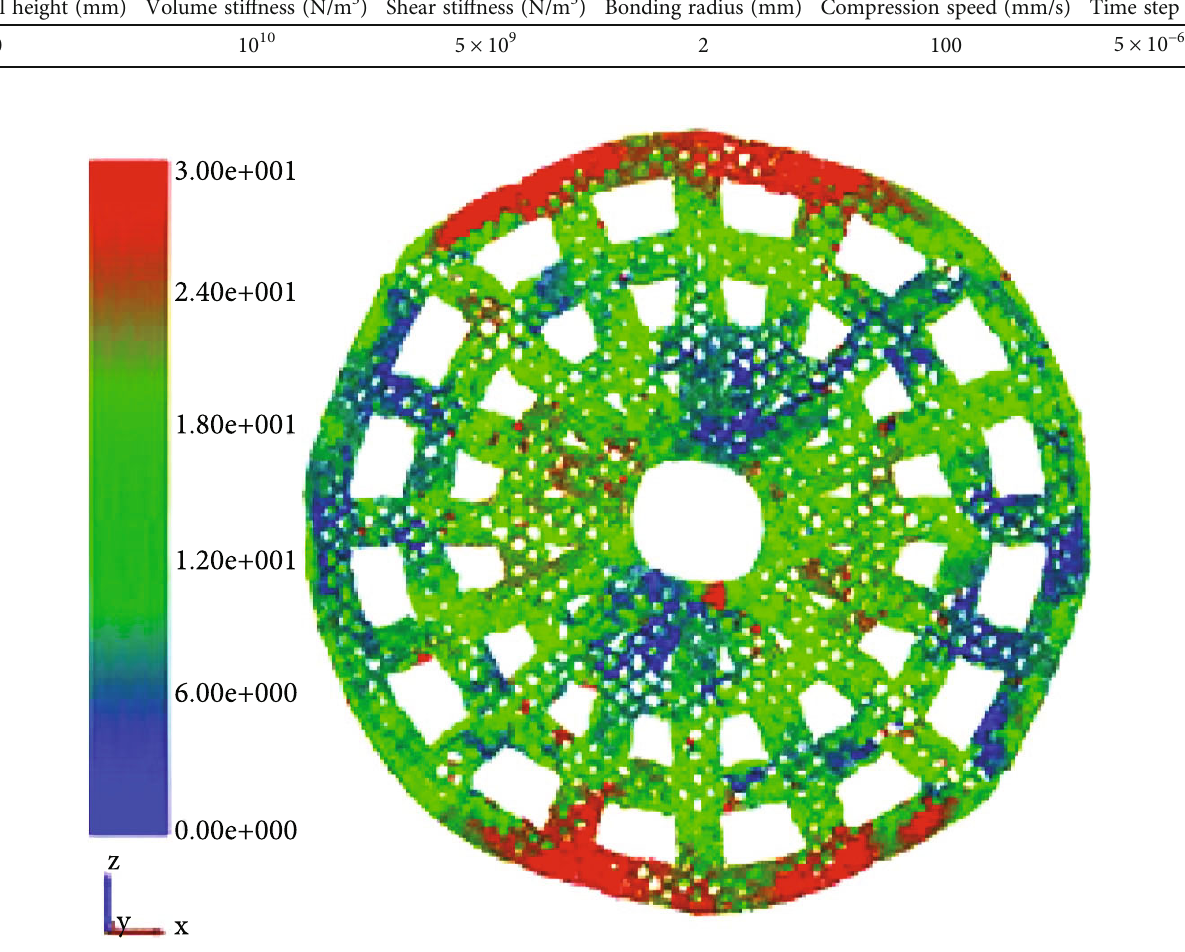
Figure 17: Compression deformation of spider web honeycomb.